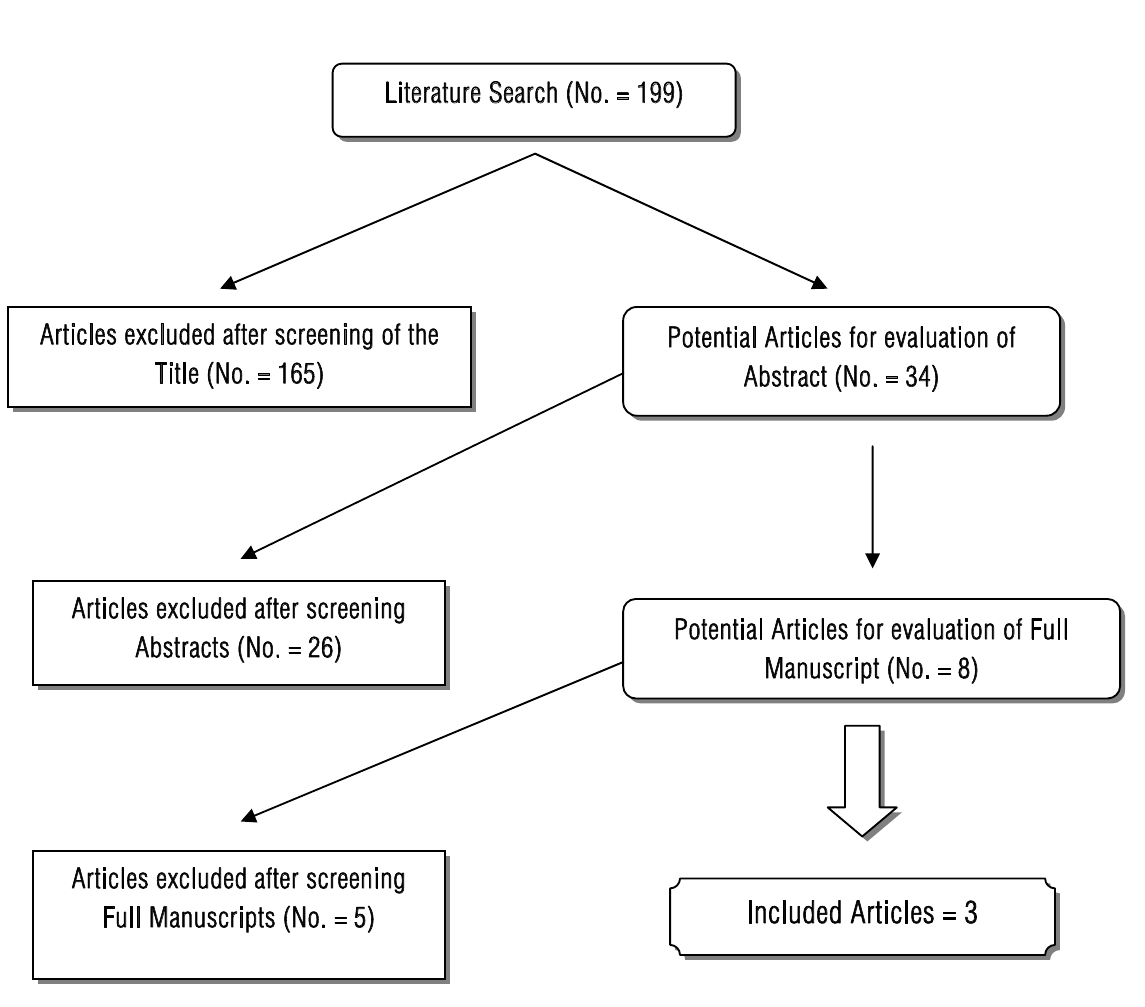
Figure 1 figure 1 - flowchart for article selection process of the review. Flowchart for article selection process of the